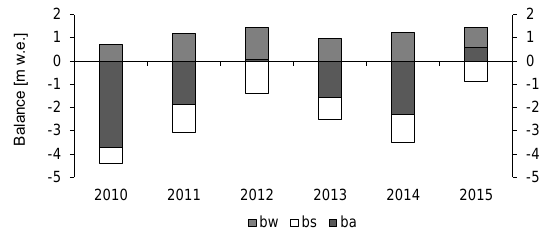
Figure 8. Mass balance measurements at stake J2 on Juvfonne: bw – balance winter, bs – balance summer, ba – annual (net) balance (Fig. 3a for position of stake).